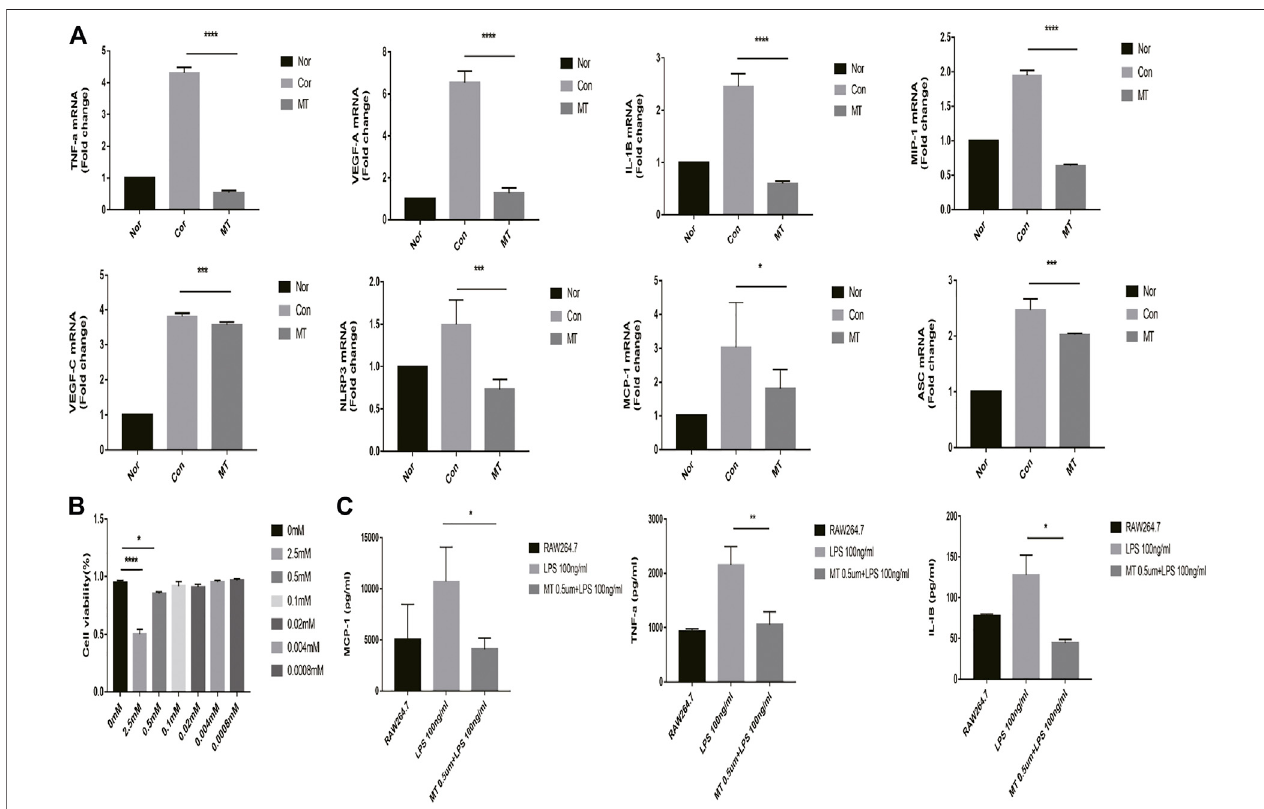
FIGURE 5 | MT inhibits the expression of in fl ammatory cytokines in RAW264.7 macrophages. (A) mRNA expression of in fl ammatory cytokines was measured by real-time quantitative PCR ( n (cid:1) 4 per group). (B) The cell viability was determined by CCK8 assay ( n (cid:1) 4 per group). (C) Protein expression of in fl ammatory cytokines in culture supernatants was measured by ELISA ( n (cid:1) 4 per group). (Nor: Normal group; Con: control group; MT: treated with MT). * p < 0.05, ** p < 0.01, *** p < 0.001.